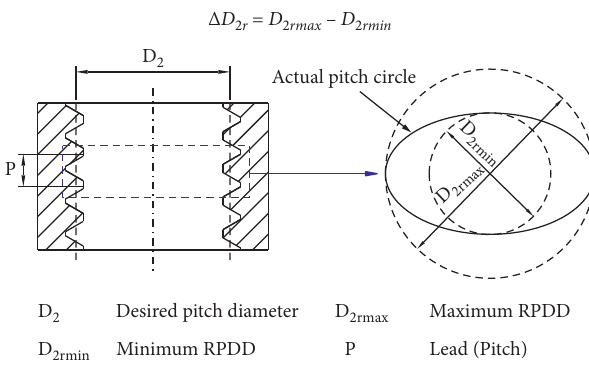
Figure 1: Schematic diagram of